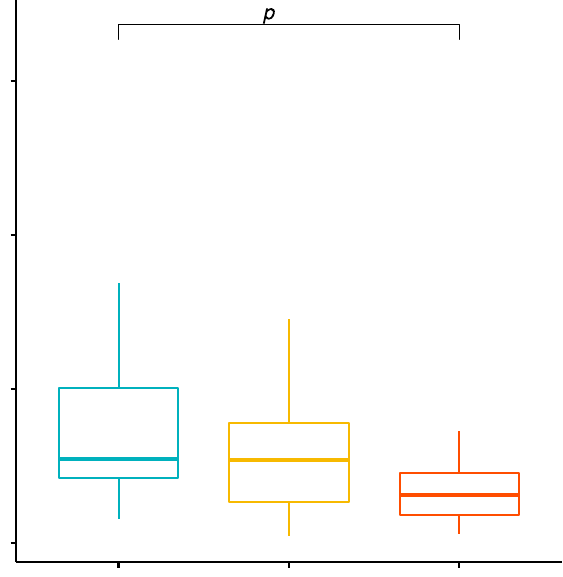
Figure 4. Percentage of CD19+/TLR-2+ B cells (among CD19+ cells) in patients with GD before treatment, after euthyroidism and in the control group.